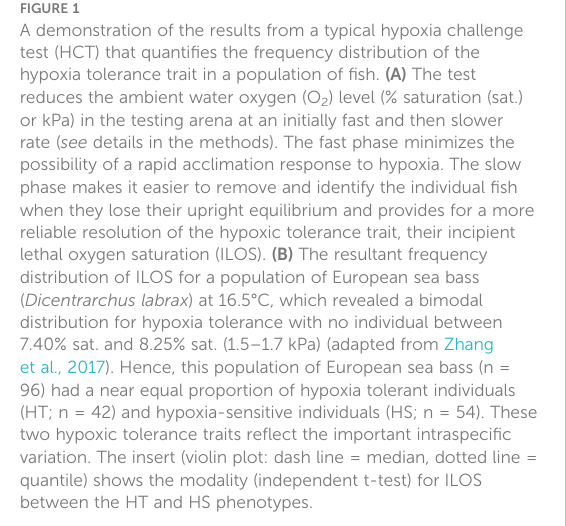
(Figure 1A). Each time a fi sh reaches its LOE, the ambient PO 2 (or the time-to-LOE) is recorded as an index of an individual fi sh ’ s hypoxic tolerance ( fi sh can be individually tagged to facilitate monitoring and follow-up). The fi sh are quickly recovered by rapidly transferring them from the experimental arena into a well-aerated aquarium at the same temperature. If researchers are interested in characterizing the responses of tissues and organs under hypoxic conditions, fi sh can be terminally sampled at or immediately after LOE following the 3Rs principle in animal welfare. The individuals with extreme hypoxic tolerance (e.g., top and bottom 10% of the population)